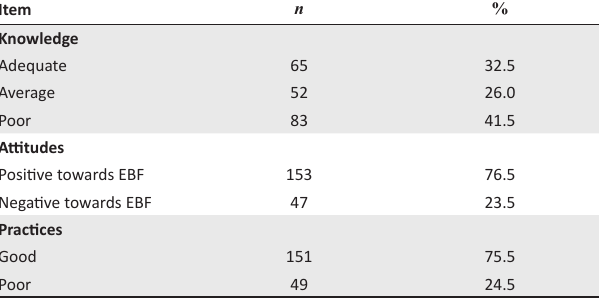
TABLE 5: Outcome of knowledge, attitudes and practices assessment.